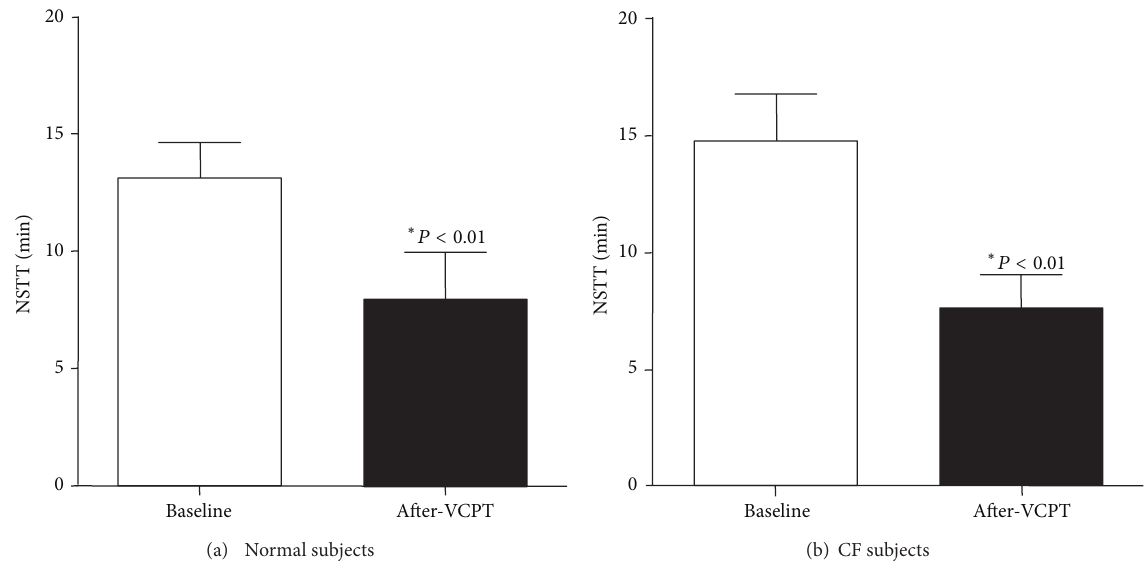
Figure 3: Aggregate nasal saccharin transit time after VCPT. (a) Normal subjects demonstrated a 35% decrease in NSTT following VCPT as compared to pretreatment NSTT ( 13.0 ± 1.9 minutes versus 8.4 ± 2.3 min; 𝑃 < 0.01 ). (b) In CF subjects, we observed a similar 38% decrease in NSTT after VCPT when compared to pretreatment values (baseline = 15.5 ± 1.6 min versus after vest = 8.3 ± 1.6 min; 𝑃 < 0.01